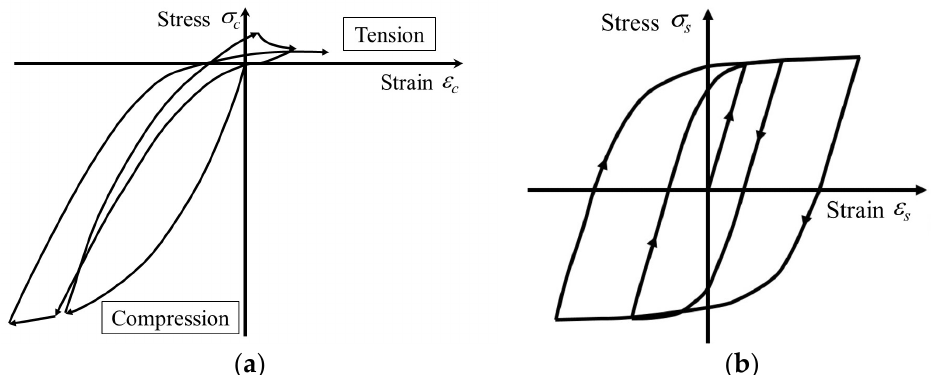
Figure 15. Stress–strain hysteretic model: ( a ) concrete; ( b ) steel.